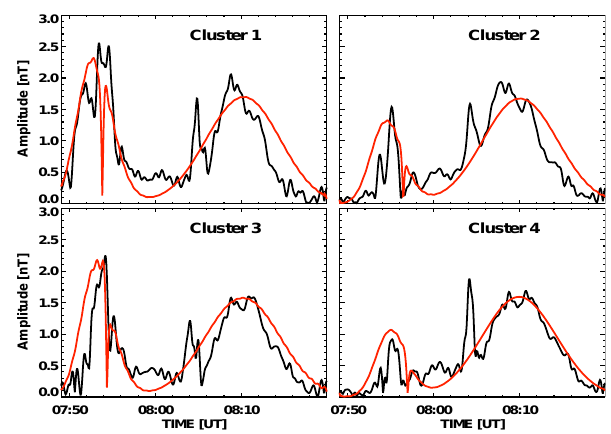
Fig. 12. Instantaneous amplitudes of the radial magnetic field com- ponent b r : observed signal (black) and modeled signal